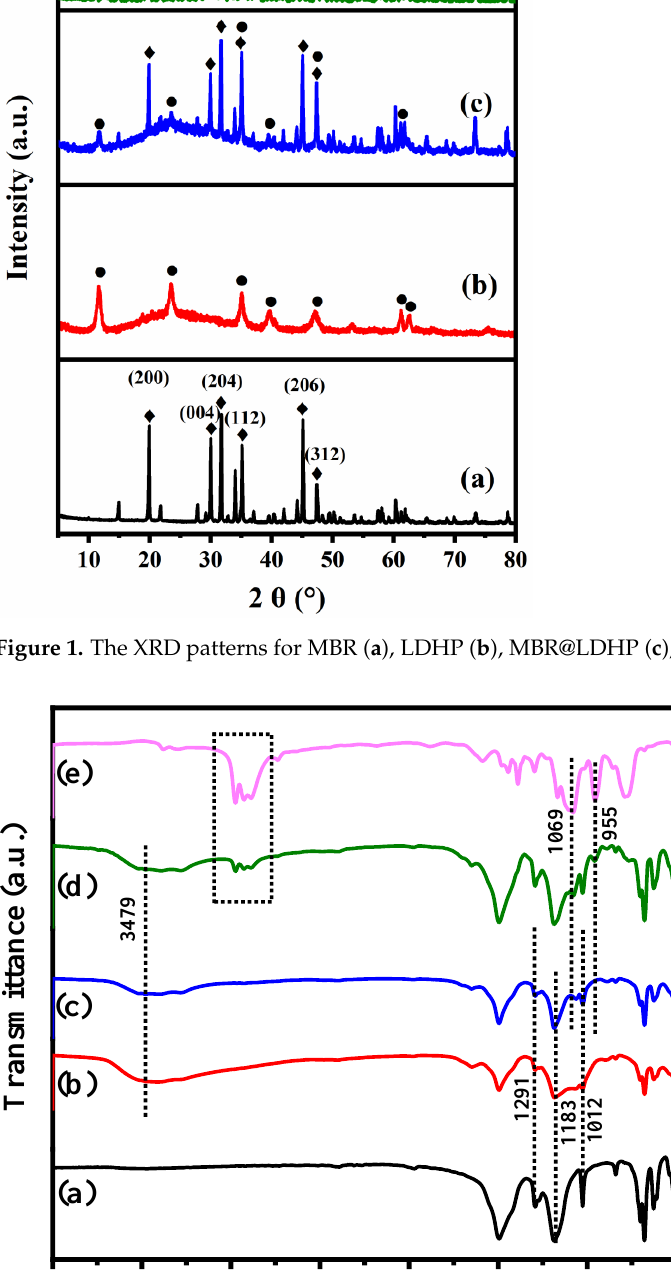
Figure 2. FTIR spectra of MBR ( a ), LDHP ( b ), MBR@LDHP ( c ), MBR@LDHP-APES ( d ), and DDP ( e ). 227 The SEM images displaying the morphologies and structures of (a) MBR, (b) LDHP, 228 (c) MBR@LDHP, and (d) MBR@LDHP-APES are depicted in Figure 3. As observed, MBR 229